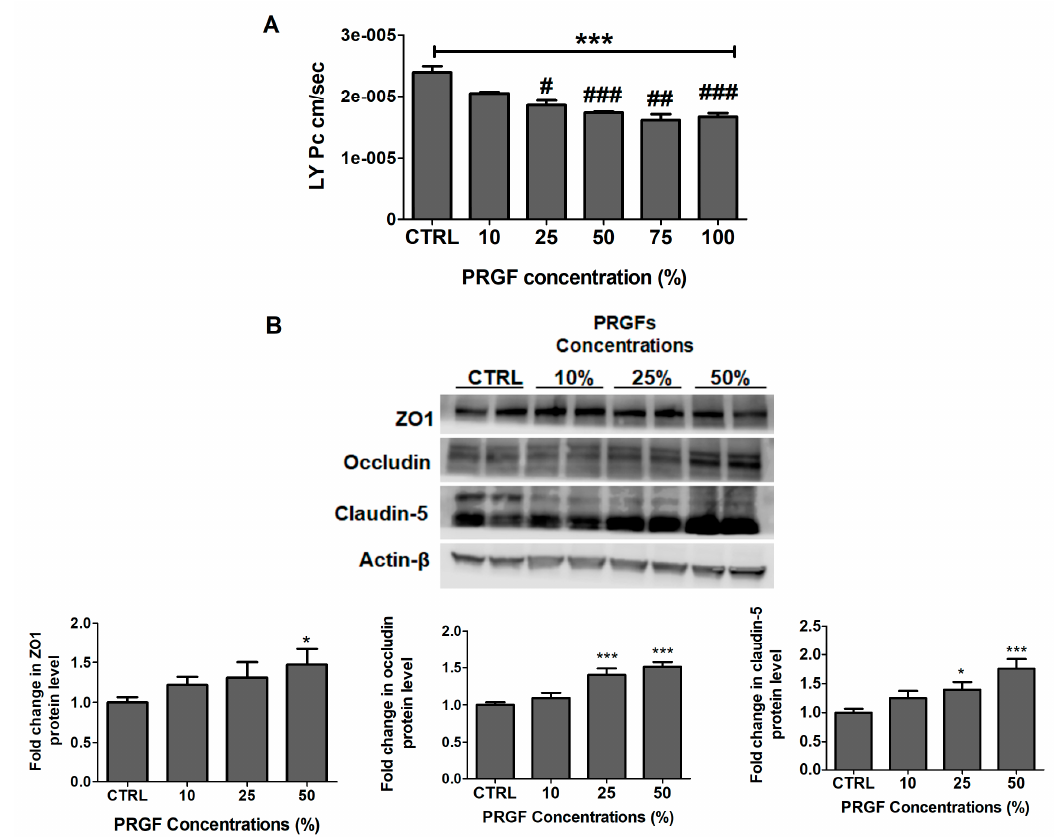
Figure 1. PRGF increased cell-based BBB tightness in-vitro. ( A ) Concentration-dependent decrease in LY permeation (PC) across the bEnd-3 cells-based BBB model. Data represented as mean ± SD of 3 independent experiments with n = 4 wells/treatment/experiment. ( B ) Representative blots and densitometry analysis of tight junction proteins demonstrated a concentration-dependent increase of ZO1, occludin, and claudin-5. Data are presented as mean ± SD of three independent experiments with n = 3 dishes/treatment group/experiment. * p < 0.05, *** p < 0.001 compared to control (CTRL) group. # p < 0.05, ## p < 0.01, and ### p < 0.001 compared to PRGF 10% dilution.